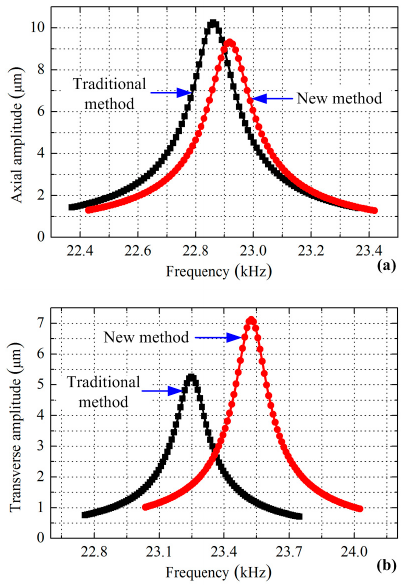
Figure 5. Comparison of the vibration amplitudes of the driving tip between different exciting methods by FEM: ( a ) axial amplitude under longitudinal vibration; ( b ) transverse amplitude under bending vibration. Figure 5a indicates that the transducer can achieve the maximum axial amplitude of 10.2 µm at